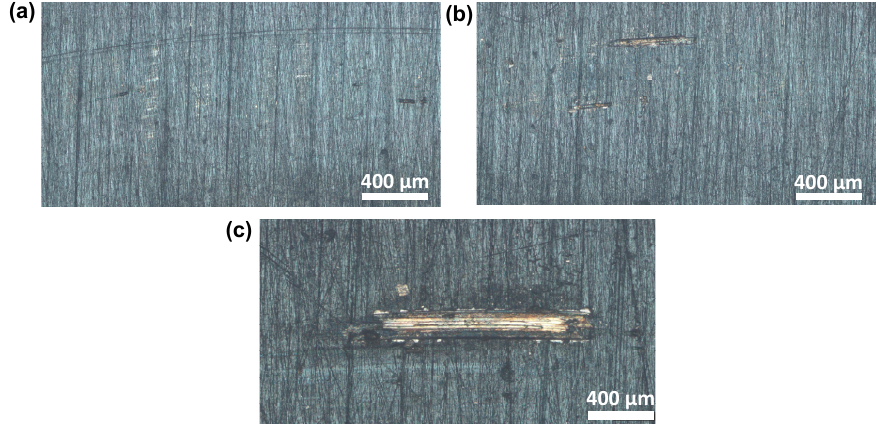
Figure 14. Optical morphologies of TiCN coating wear scars in oil: ( a ) 43 N; ( b ) 86 N; and ( c ) 106 N.